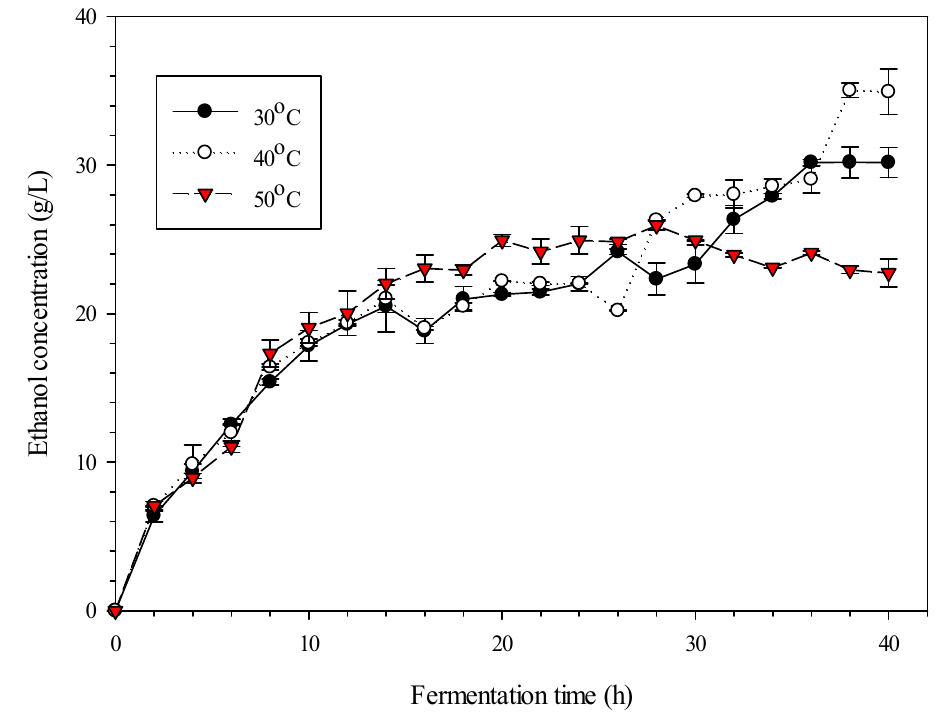
Figure 7. E ff ect of temperature on fermentation of treated Napier grass using an eight-blade turbine Figure 7. Effect of temperature on fermentation of treated Napier grass using an eight - blade turbine impeller at a pH level of 5, an agitation speed of 70 rpm, and 2 wt % yeast. impeller at a pH level of 5, an agitation speed of 70 rpm, and 2 wt % yeast .